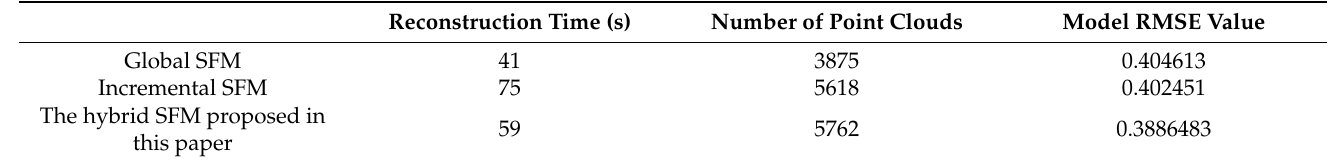
Table 2. Dataset “doll” experimental